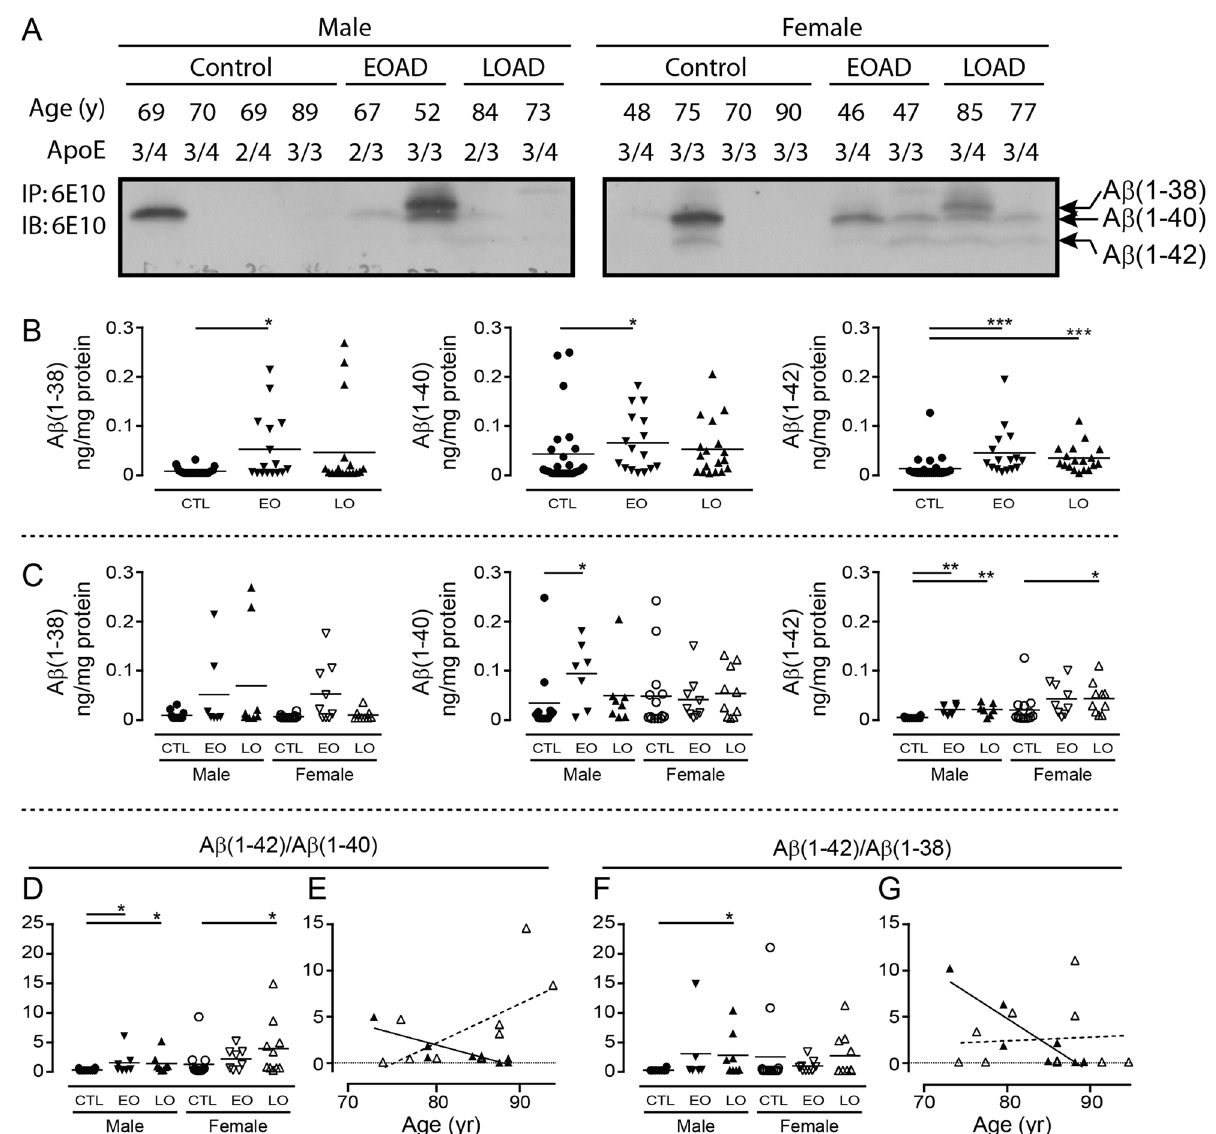
Figure 7. Levels of Aβ peptides isolated from RIPA-soluble human cortical extracts. ( A ) Representative gels showing resolved Aβ peptides isolated by 6E10-immunoprecipitation and used for densitometric analyses. Bands corresponding to Aβ(1–38), Aβ(1–40), and Aβ(1–42) are identified (based on a set of synthetic standards run separately; not shown ). Samples represent male and female donors diagnosed with Early-Onset AD (EOAD) or Late-Onset AD (LOAD), or from age- and sex-matched controls. Respective age-at-death and APOE genotype are indicated. Levels of peptides (in ng per mg protein) were analyzed by ( B ) diagnosis or ( C ) stratified by sex and diagnosis. The data were expressed as ( D ) Aβ(1–42)/Aβ(1–40) or ( F ) Aβ(1–42)/Aβ(1–38) ratios. ( E , G ) The relation between these ratios and age of the donor at autopsy were examined by regression (Pearson’s) analysis. *: P < 0.05; **: P < 0.01; ***: P < 0.001 vs. corresponding controls (CTL). EO: Early-Onset AD; LO: Late- Onset AD. An example of a full-length blot is presented in Supplementary Fig.